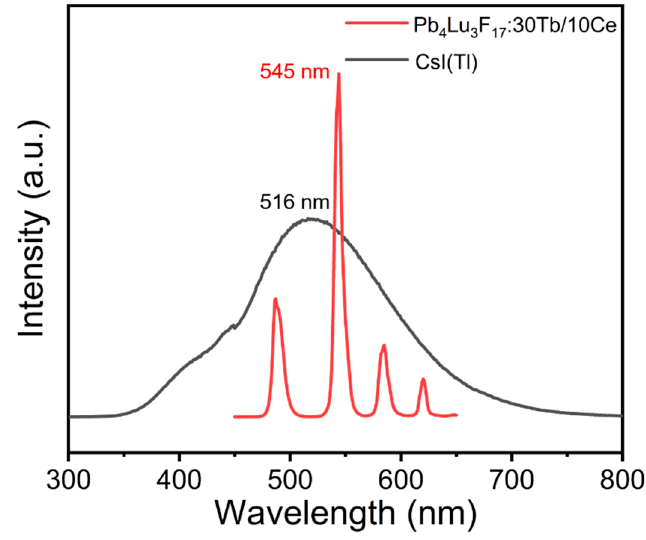
Figure 5. X-ray excited emission spectra of the Pb 4 Lu 3 F 17 : 30Tb10Ce and CsI (Tl).